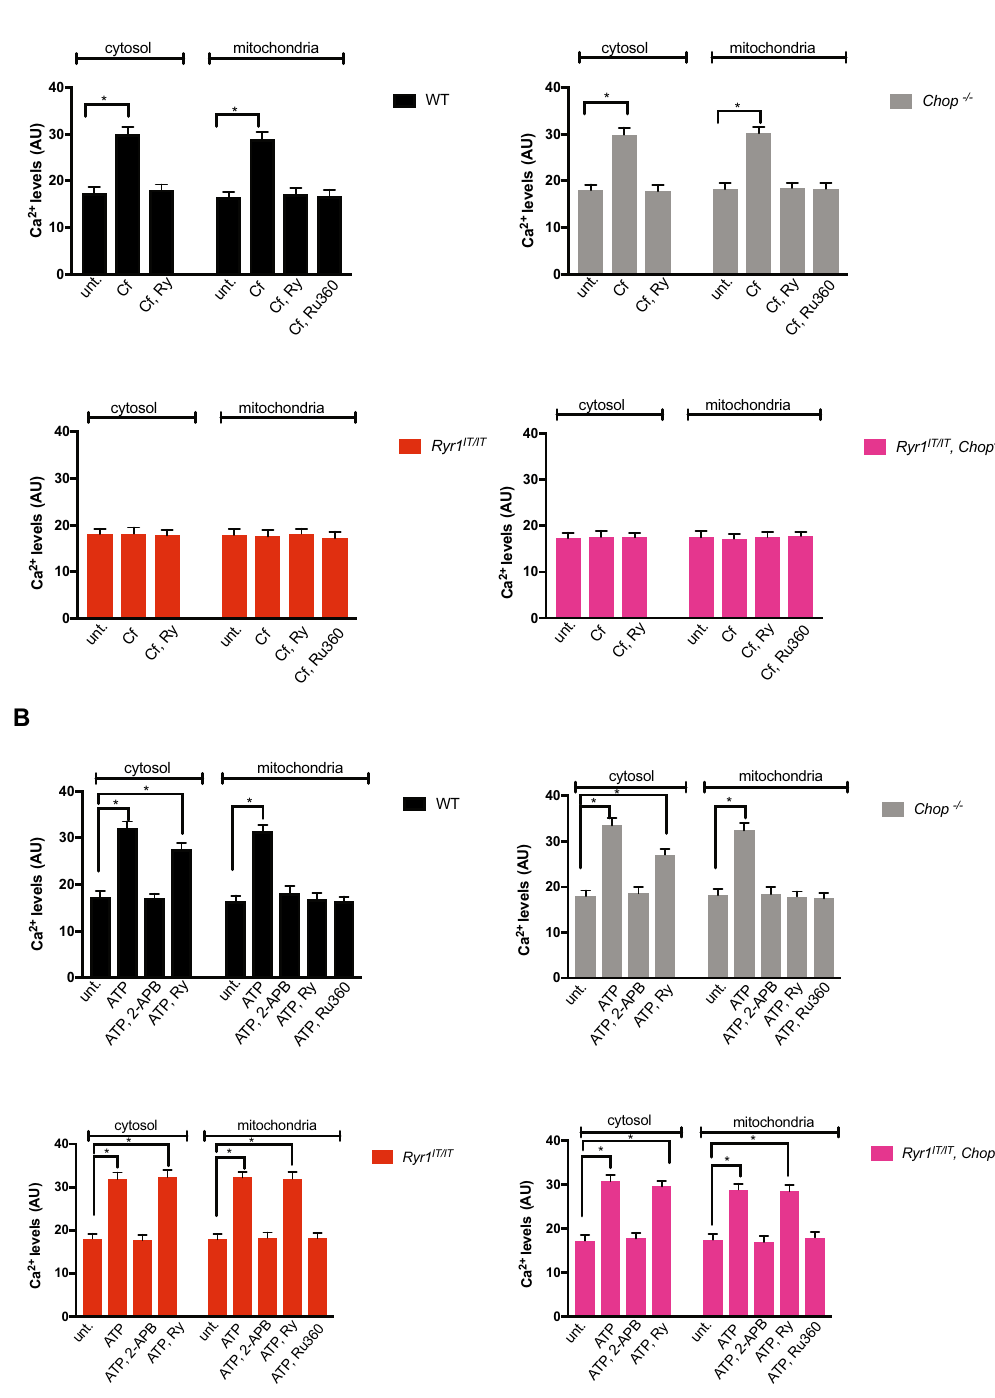
Figure 4. Calcium handling in Ryr1 I4895T/I4895T and in Ryr1 I4895T/I4895T , Chop −/− cells. ( A ) Bar graphs depicting the effects of caffeine (Cf, an agonist of the RYR), Ryanodine (Ry, an inhibitor of the RYR) and Ru360 (an inhibitor of mitochondrial calcium uptake) on calcium levels in cytosol (detected by the Fluo 4 probe) and in mitochondria (detected by the Rhod 2 probe) in the MEFs of the indicated genotypes. ( B ) Bar graphs depicting the effects of ATP (an agonist of IP3r), 2-APB (an inhibitor of IP3r), Ry and Ru360 on calcium levels in cytosol (detected by the Fluo 4 probe) and in mitochondria (detected by the Rhod 2 probe) in the MEFs of the indicated genotypes. For clarity, the value of untreated cells is duplicated and presented in panels ( A ) and ( B ). Results are the means ± SD calculated from three separate experiments (ANOVA followed by Dunnett’s